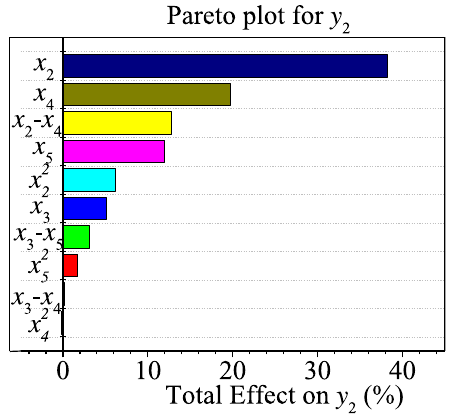
Fig. 14. Pareto diagram of optimization objective y 2 .